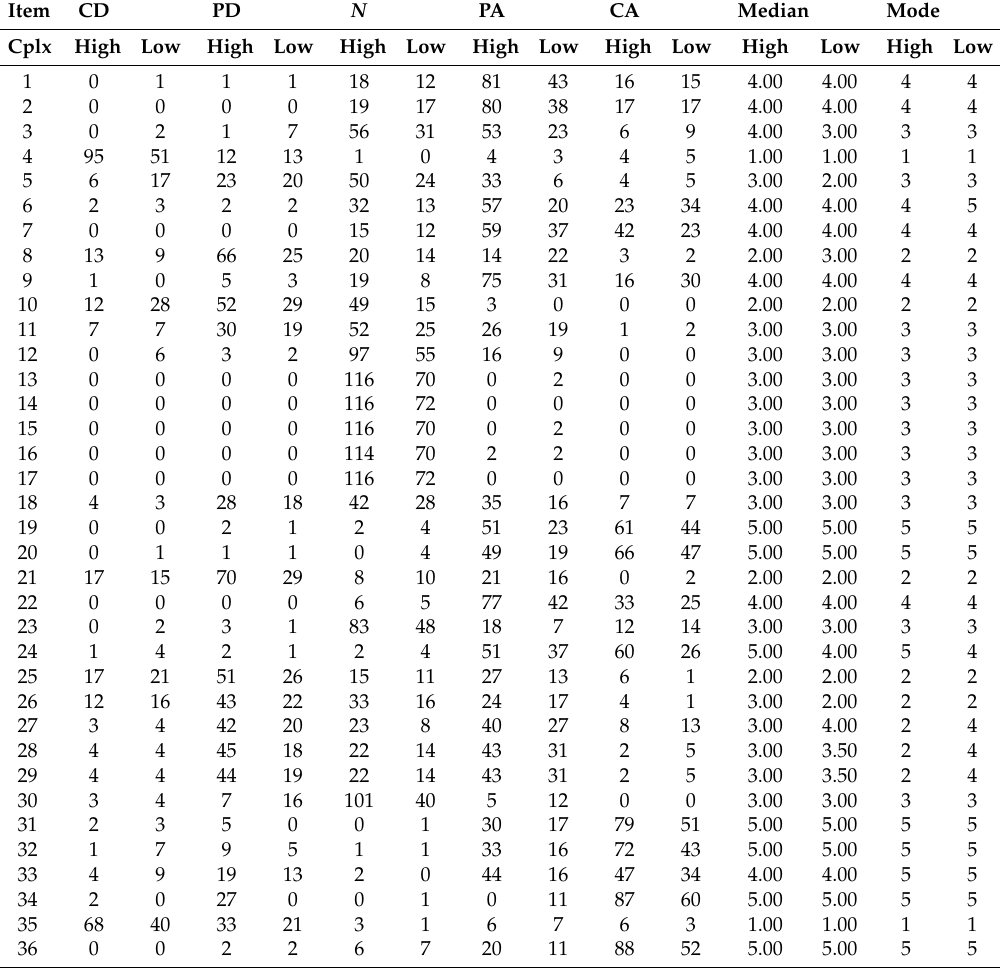
Table 1. Likert rank-order scale of ordinal qualitative